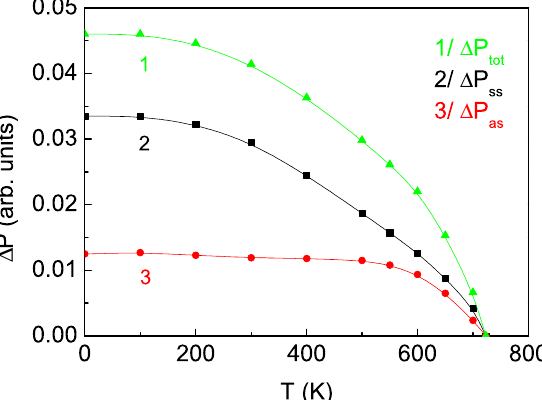
Figure 4. Temperature dependence of the total spin-assisted polarization ∆ P tot curve (1) due to the contributions of the MS ∆ P ss (curve 2) and the antisymmetric DM magnetic interaction ∆ P as (curve